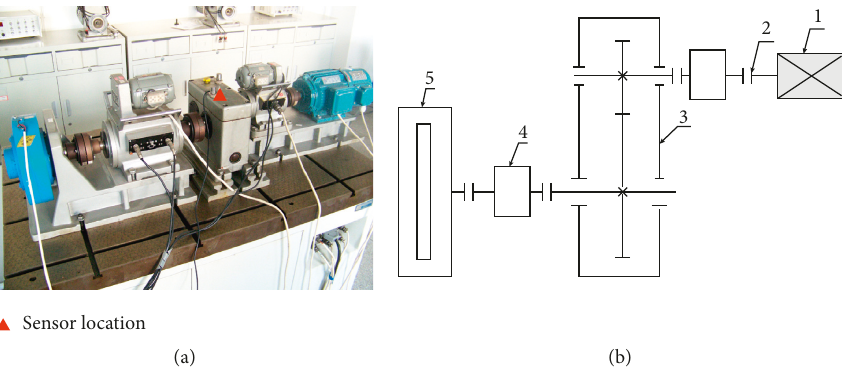
Figure 24: Gear signal testing device. (a) Physical object of the device and (b) structure diagram of test device: (1) AC motor; (2) coupling; (3) gearbox; (4) dynamometers; and (5) magnetic powder brake.